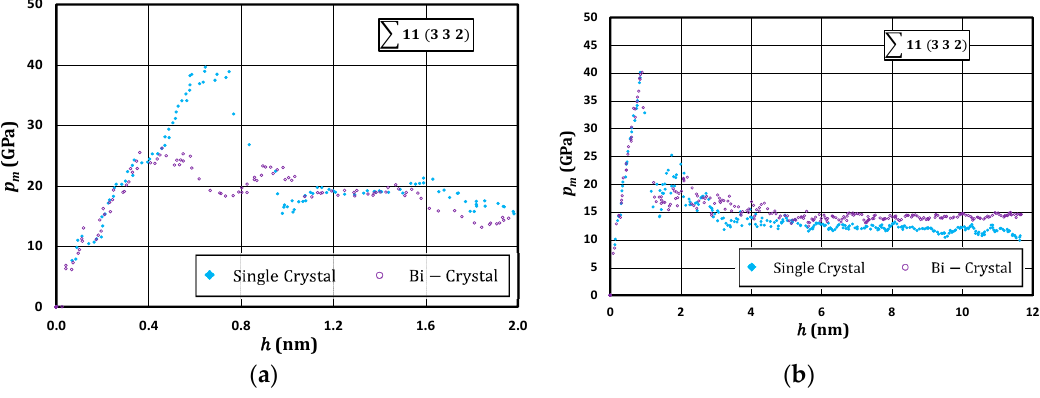
Figure 21. Effect of ∑11 (3 3 2) grain boundary on the nanoindentation response of Ni thin film: ( a ) small sample and ( b ) large sample (after Voyiadjis and Yaghoobi [88]).